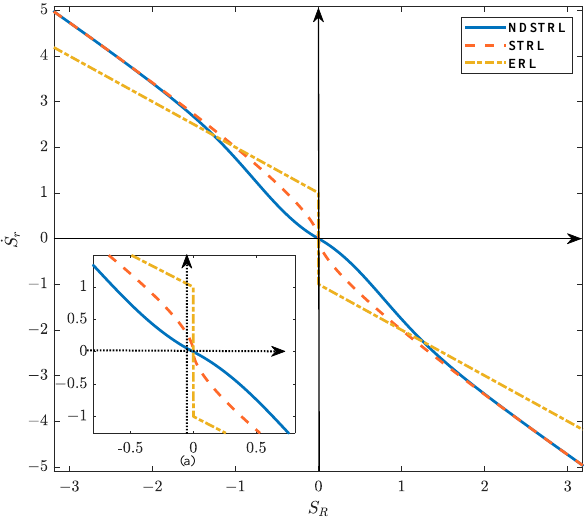
Figure 5. Comparison of NDSTRL and STRL.